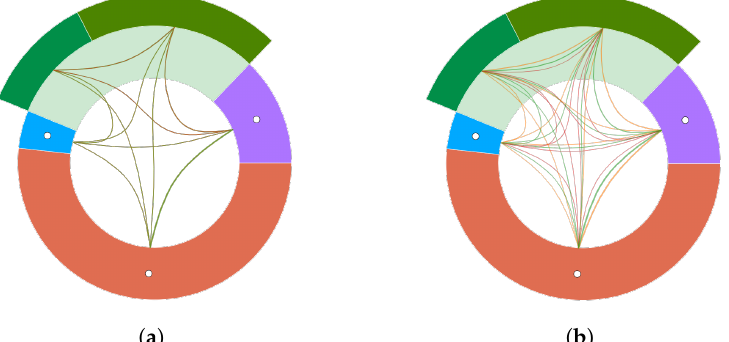
Figure 9. Carbonic supports multi-layer networks. Each type of connection is depicted in a different color and an offset can be applied to their trajectories to avoid overlapping between them. ( a ) Offset: 0. ( b ) Offset: 0.5.